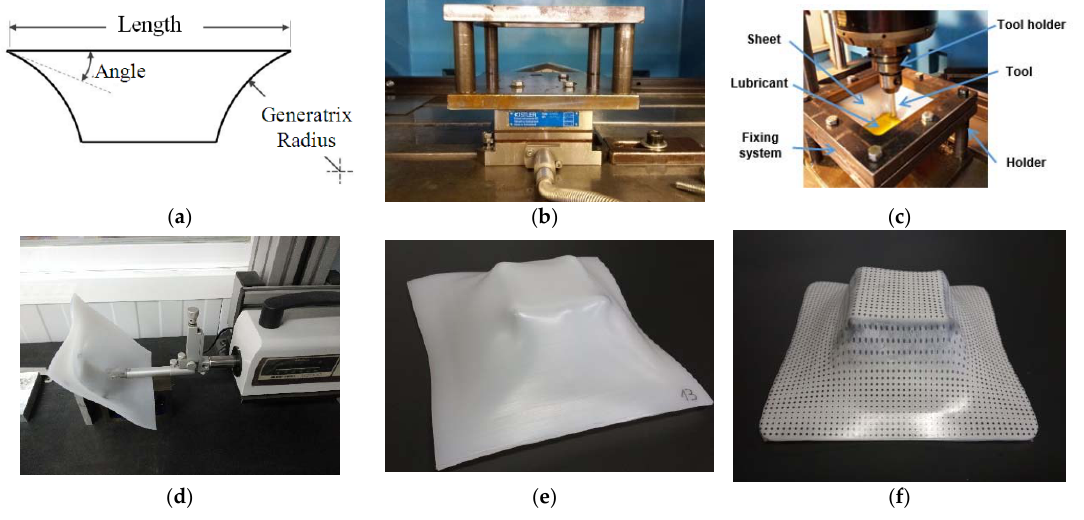
Figure 1. ( a ) Test geometry ( b ) Dynamometer with tooling ( c ) Experimental setup ( d ) Roughness measurement on ultra-high molecular weight polyethylene (UHWMPE) ( e ) UHMWPE part ( f ) polycaprolactone (PCL) part.